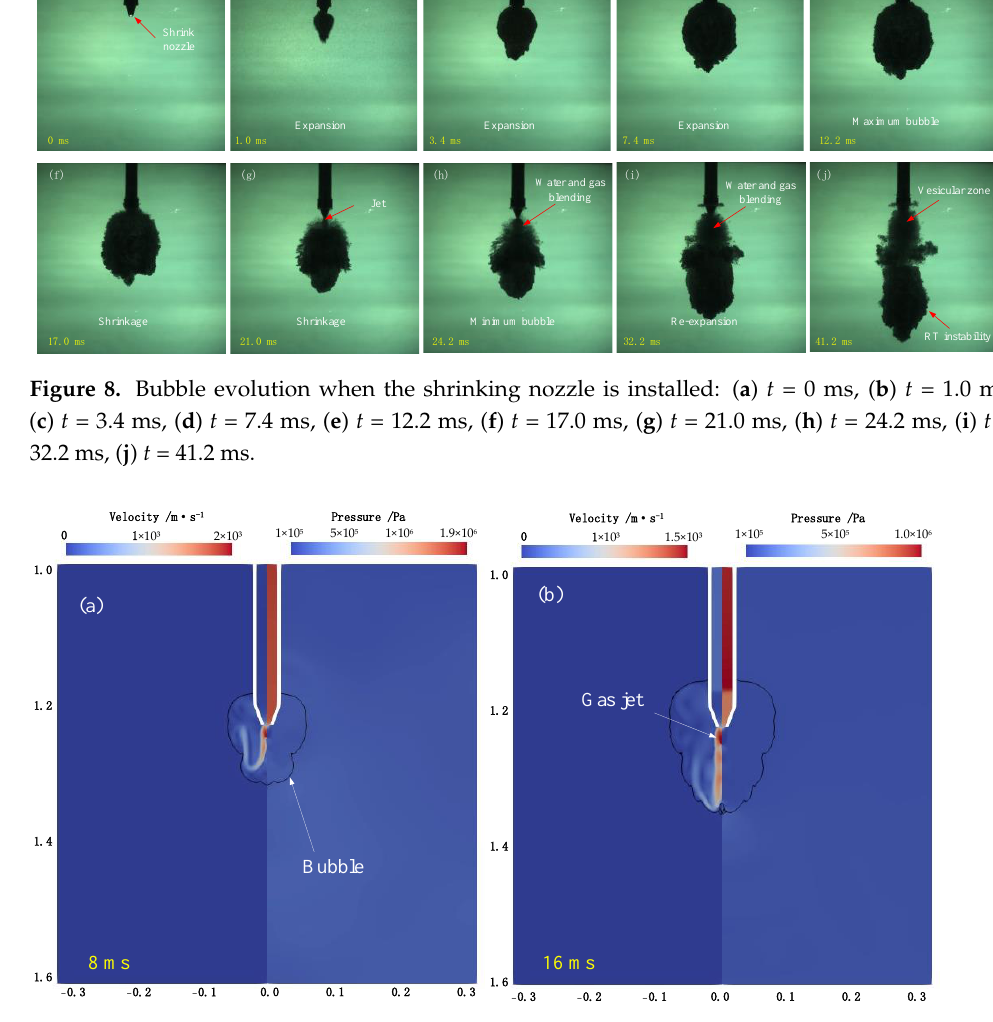
phase, the bubble did not remain spherical but instead assumed a more toroidal shape as the bottom of the bubble folded inward to create a re-entrant jet during the bubble pulse. This geometric shape change, coupled with the associated flow, assisted the bubble in its vertical migration, as mentioned previously. vertical migration, as mentioned previously.